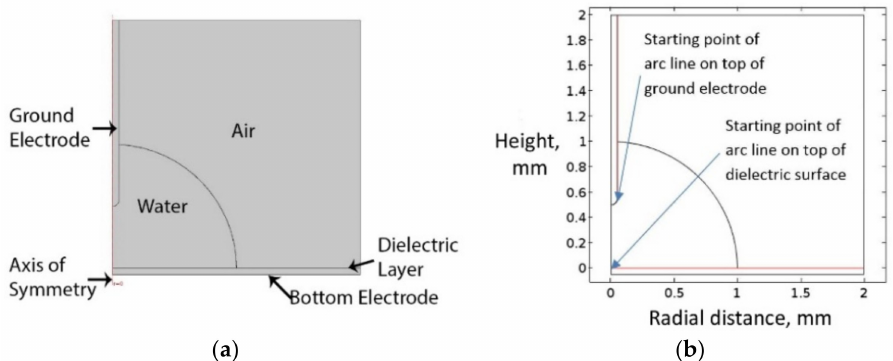
Figure 8. ( a ) Boundary conditions of the simulation study, ( b ) coordinate system for plotting the electric field magnitude and integration calculations of the resultant force on the dielectric and ground electrode